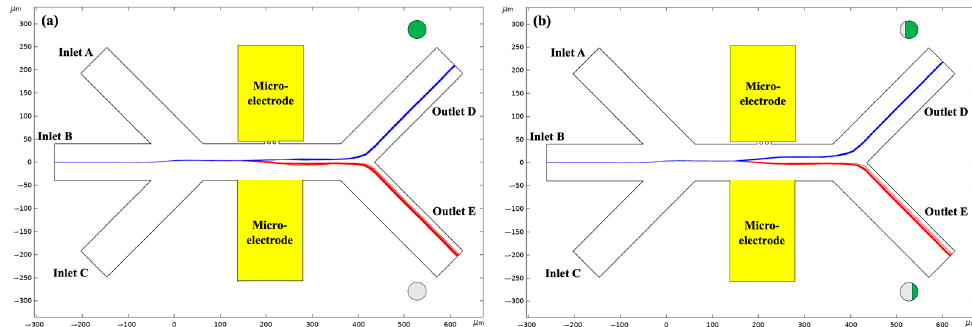
Figure 6. ( a ) The isolation of 3-micrometer Chlorella from the Chlorella fully coated with PS microplastic particles. ( b ) The separation of 3-micrometer Chlorella coated with 25% and 75% PS particles. The applied voltages were 40 and 45 volts, respectively. The thickness of the PS-particle coating was 0.6 µm and the electrical conductivity of medium used in this study was σ m = 1 × 10 − 7 S/m.